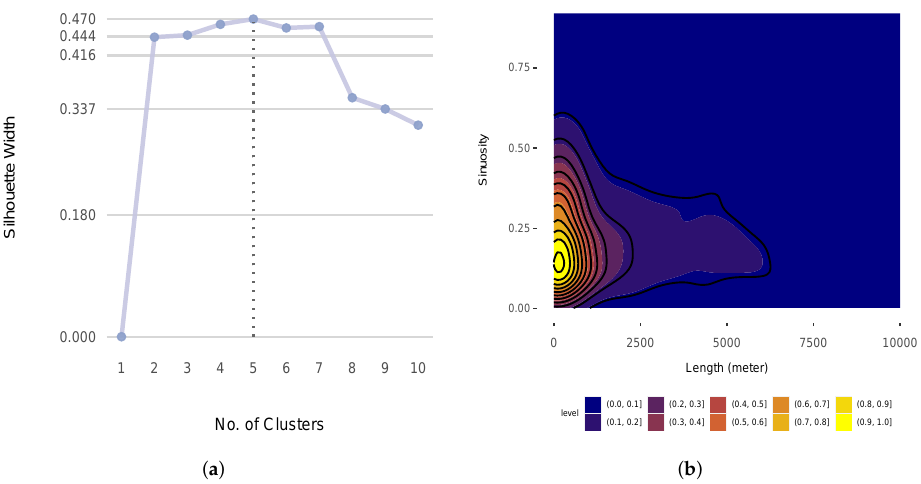
Figure 5. ( a ) The silhouette scores for the different numbers of clusters from the similarity matrix that consisted of the geometric descriptors; ( b ) a kernel density plot of the sinuosity and length of the similarity matrix that consisted of the geometric descriptors.